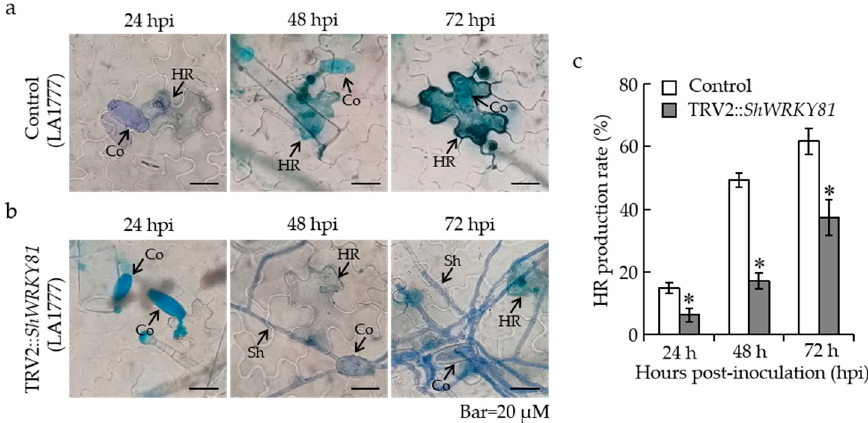
Figure 7. The silencing of ShWRKY81 reduced the generation of HR in LA1777 following On -Lz infection. Histological observation of HR production at infection sites of On -Lz in control ( a ) and ShWRKY81 -silenced LA1777 seedlings ( b ). Blue staining (trypan) shows the hypersensitive cell death. The HR production rates were calculated at 24, 48, and 72 hpi ( c ). Co, conidium; Sh, secondary hyphae; HR, hypersensitive response. Bar, 20 µM. Values are shown as the means ± standard error of three biological replicates, and statistically significant differences are represented by asterisks (Student’s t -test, *, p < 0.05).